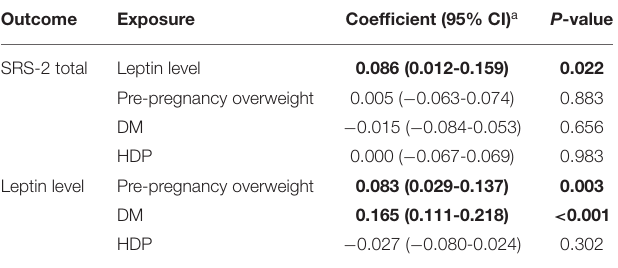
TABLE 4 | Result of the sensitivity analysis (Model